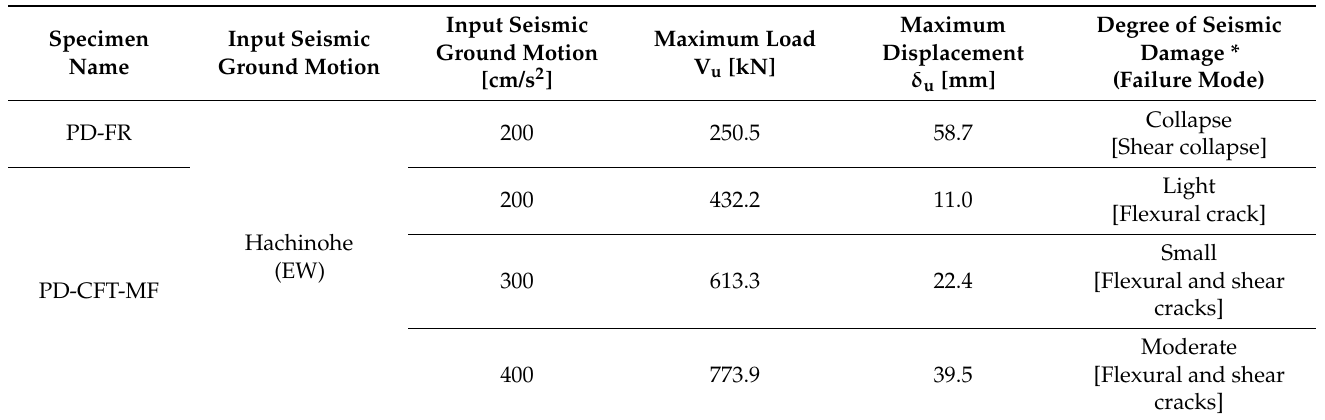
Table 4. Maximum response load-displacement and degree of seismic